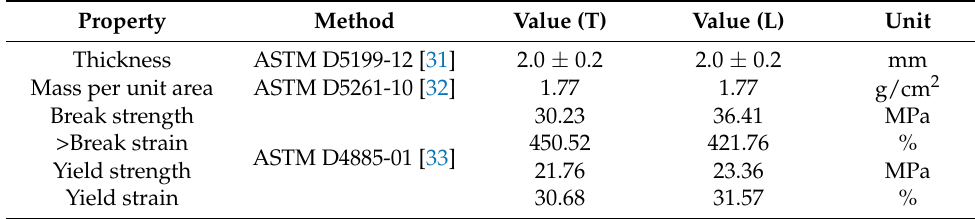
Table 1. Index properties of PVC GMBs.